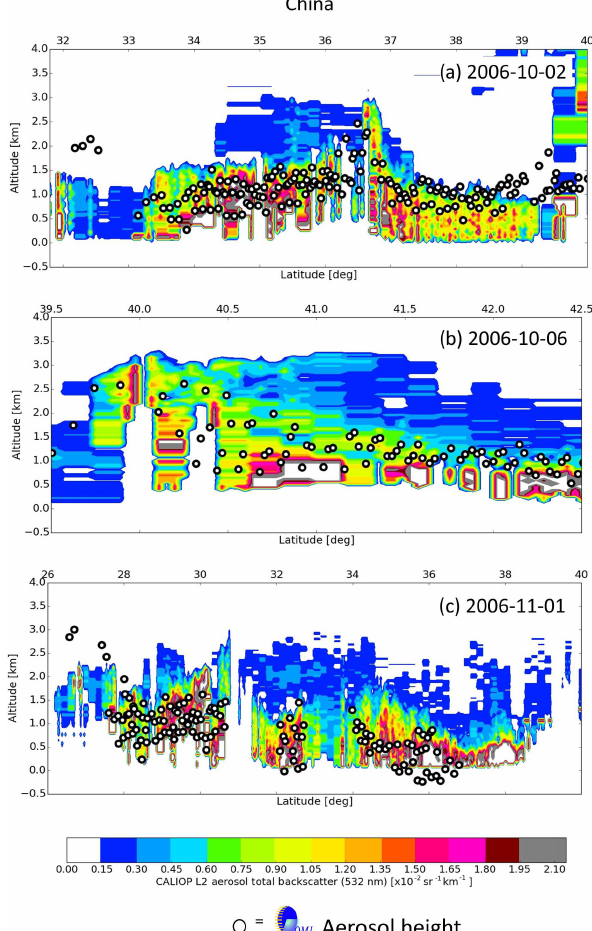
Figure 3. Retrieved OMI ALH compared with vertical profile of aerosol total backscatter coefficient (532nm) from the CALIOP L2 product. Maximal distance between OMI pixels and CALIOP ground track is 50km. Only cloud-free OMI pixels, collocated with Aqua MODIS Collection 6 aerosol cells, τ( 550nm ) ≥ 0 . 55 (from the MODIS DT and DB algorithms), are selected: (a) 2 Octo- ber 2006, (b) 6 October 2006, and (c) 1 November